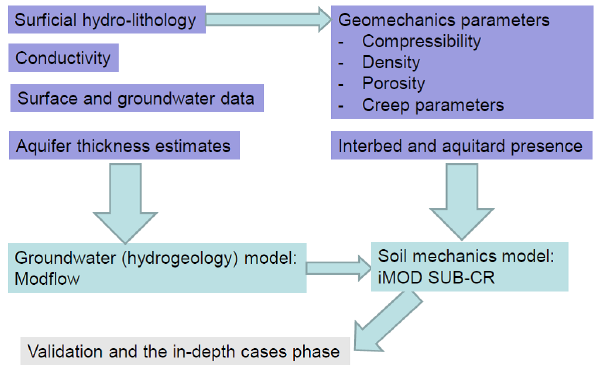
Figure 1. The proposed model suite to derive a global land sub- sidence map consists of three coupled models: the surface water model, the ground water model and a soil mechanics